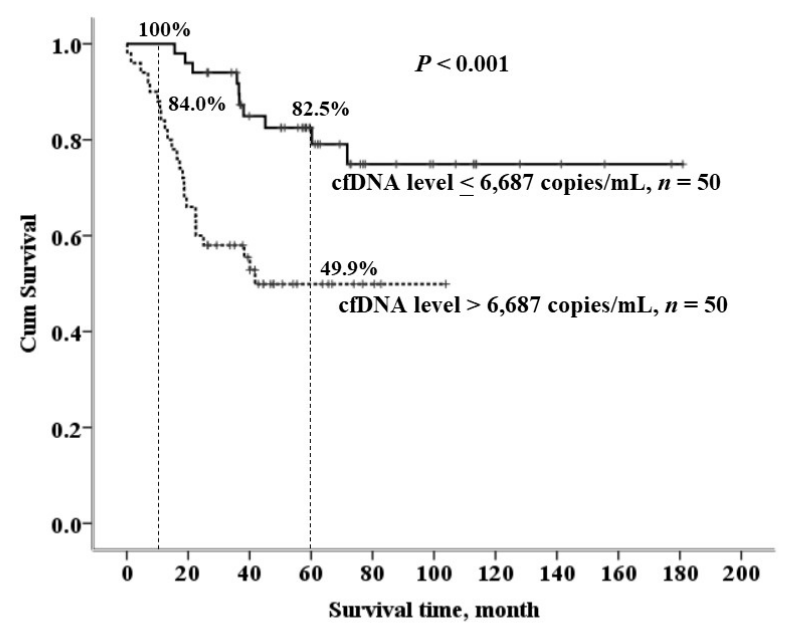
Figure 3. Survival outcomes for patients with pancreatic head adenocarcinoma after pancreaticoduo- denectomy (PD) with high and low cfDNA levels.